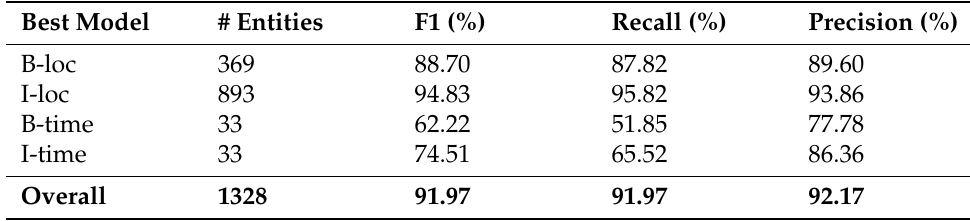
Table 10. Performance of re-trained SpaCy.